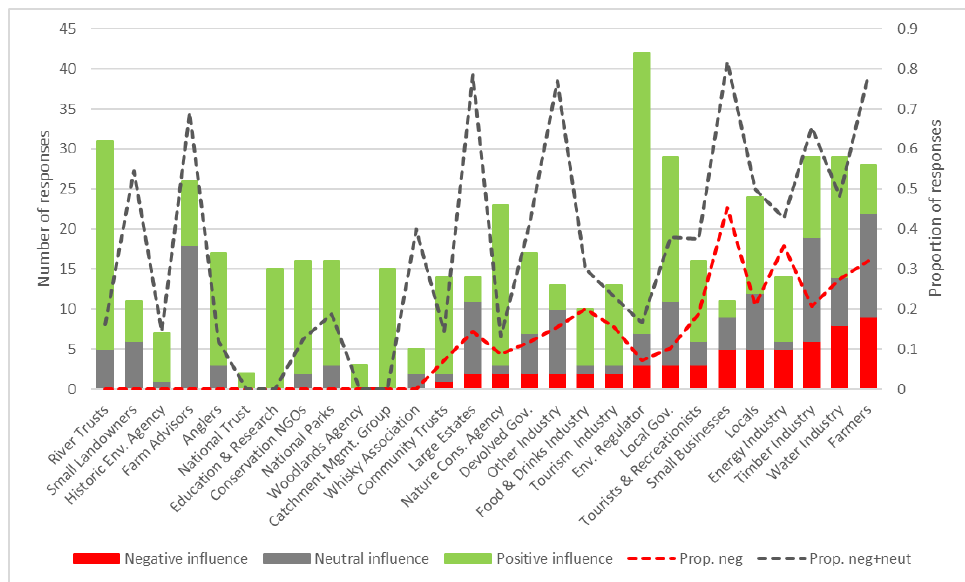
Figure 3. Number of responses of perceived negative, neutral or positive influence of the stakeholders named by participants, ranked by perceived negative influence ( N = 43, stacked bar graphs); and proportion of responses that were negative (red) or negative and neutral (grey, dotted line graphs). Table 1. Mean number of responses, mean degree, perceived influence, and proportion of perceived negative influence and negative and neutral influence of the three contrasting catchments and four key water management stakeholders (± 1 standard error). None of these statistics were significantly different between catchments or stakeholder groups (significance of differences between the means at 0.05 level).